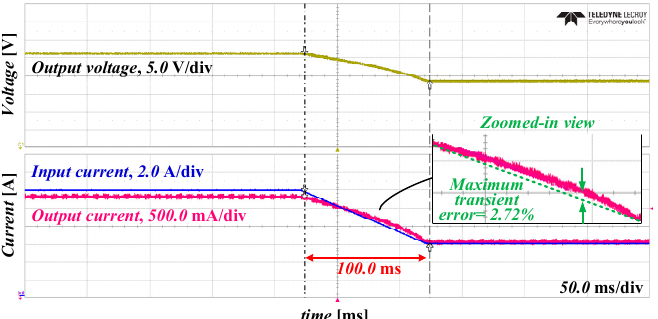
Figure 21. Experiment results: Dynamic response of input current when simulating partial shading.